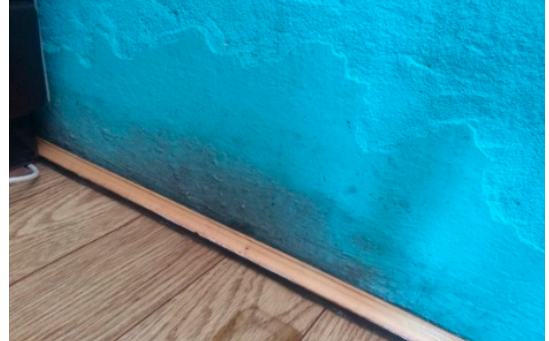
Figure 1. Microbiological infection in closed rooms: visible mold on the wall.